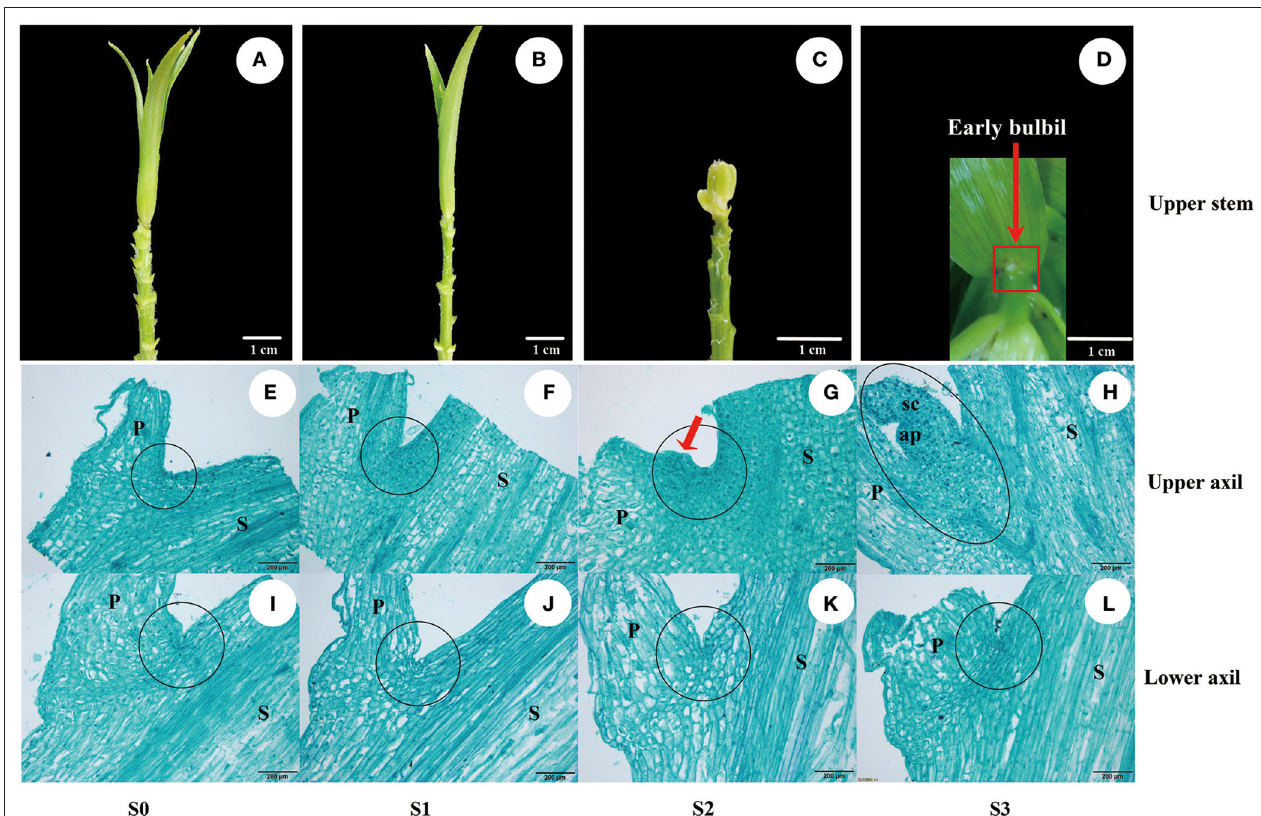
FIGURE 1 | Bulbil formation in L . lancifolium . (A–D) Stages of bulbil formation in the upper leaf axil: (A,B) S0 and S1 stages exhibiting apparent upper internodes; (C) S2 stage exhibiting swelling; (D) S3 stage exhibiting a white dot structure (early bulbil). (E–L) Microscopy images of paraffin-embedded samples of leaf axils located on the upper (E–H) and lower stem (I–L) from four stages (S0–S3). Scale bar for samples images = 1 cm; Scale bar for microscopy images = 200 µ m. P, Petiole; S, stem; sc, scale; ap, apical point; black circle, leaf axil.